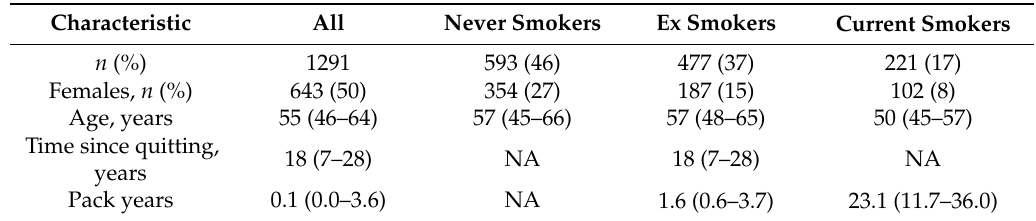
Table 1. Characteristics of study individuals.